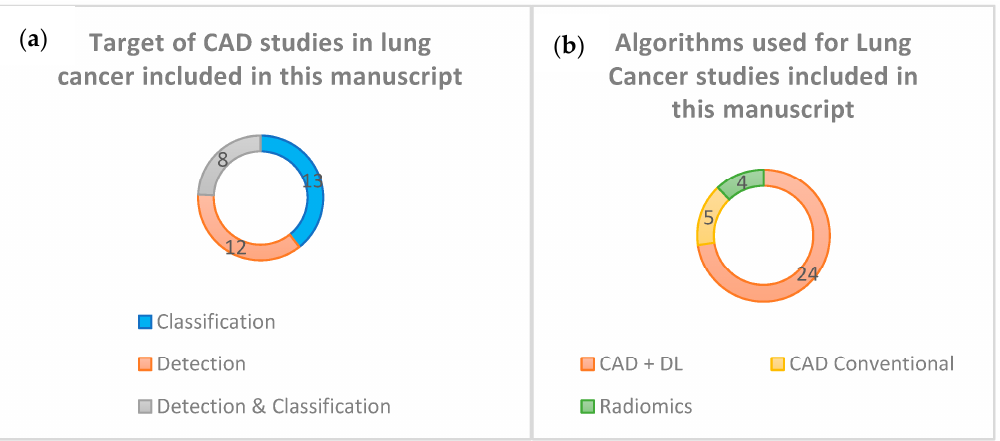
Figure 2. ( a ) Target of CAD studies about Lung Cancer included in this manuscript. ( b ) Algorithms used for Lung Cancer studies included in this manuscript.